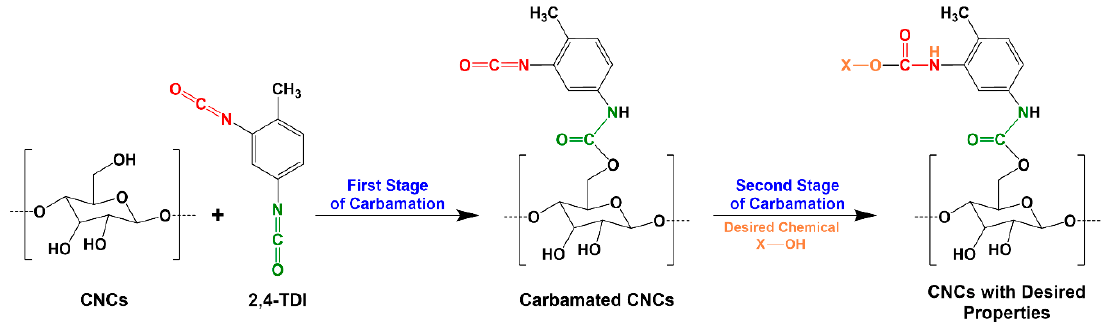
Figure 1. The functionalization of cellulose nanocrystals (CNCs) with a desired chemical using 2,4-toluene diisocyanate (TDI) as a linker [23].